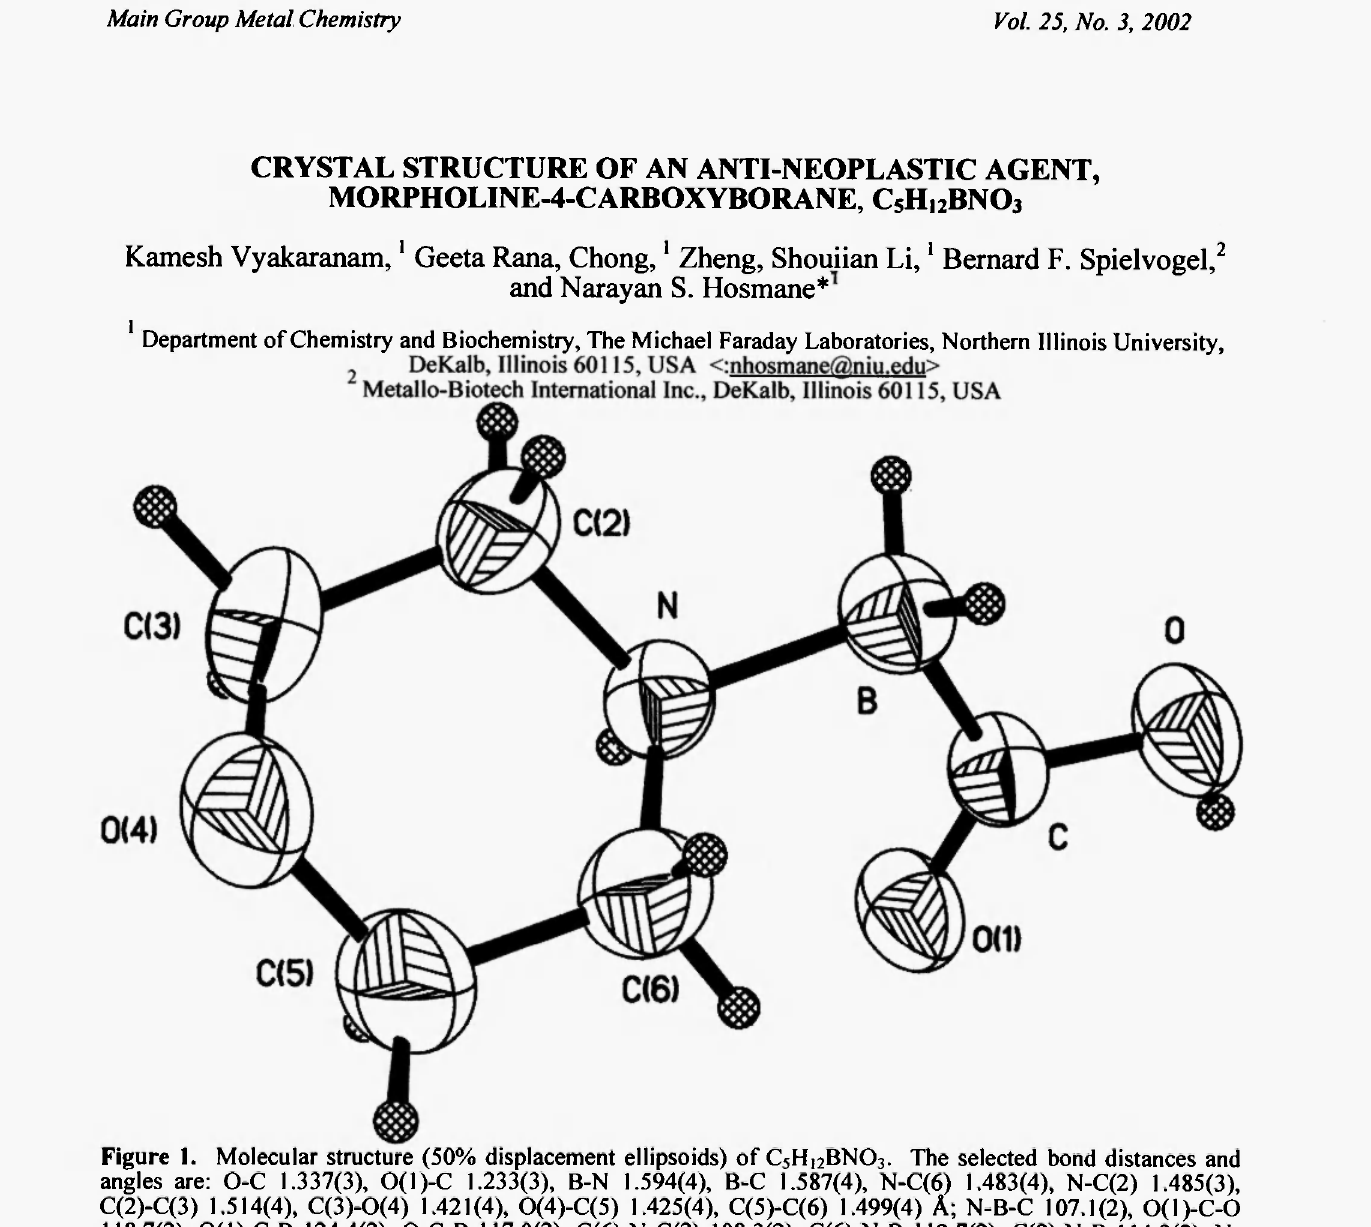
Figure 1. Molecular structure (50% displacement ellipsoids) of C5H12BNO3. The selected bond distances and angles are: O-C 1.337(3), 0(1)-C 1.233(3), B-N 1.594(4), B-C 1.587(4), N-C(6) 1.483(4), N-C(2) 1.485(3), C(2)-C(3) 1.514(4), C(3)-0(4) 1.421(4), 0(4)-C(5) 1.425(4), C(5)-C(6) 1.499(4) A; N-B-C 107.1(2), 0(l)-C-0 118.7(2), 0( 1 )-C-B 124.4(2), O-C-B 117.0(2), C(6)-N-C(2) 108.3(2), C(6)-N-B 112.7(2), C(2)-N-B 114.3(2), N- C(2)-C(3) 111.6(2), 0(4)-C(3)-C(2) 111.2(3), C(3)-0(4)-C(5) 109.4(2), 0(4)-C(5)-C(6) 111.0(3), N-C(6)-C(5)